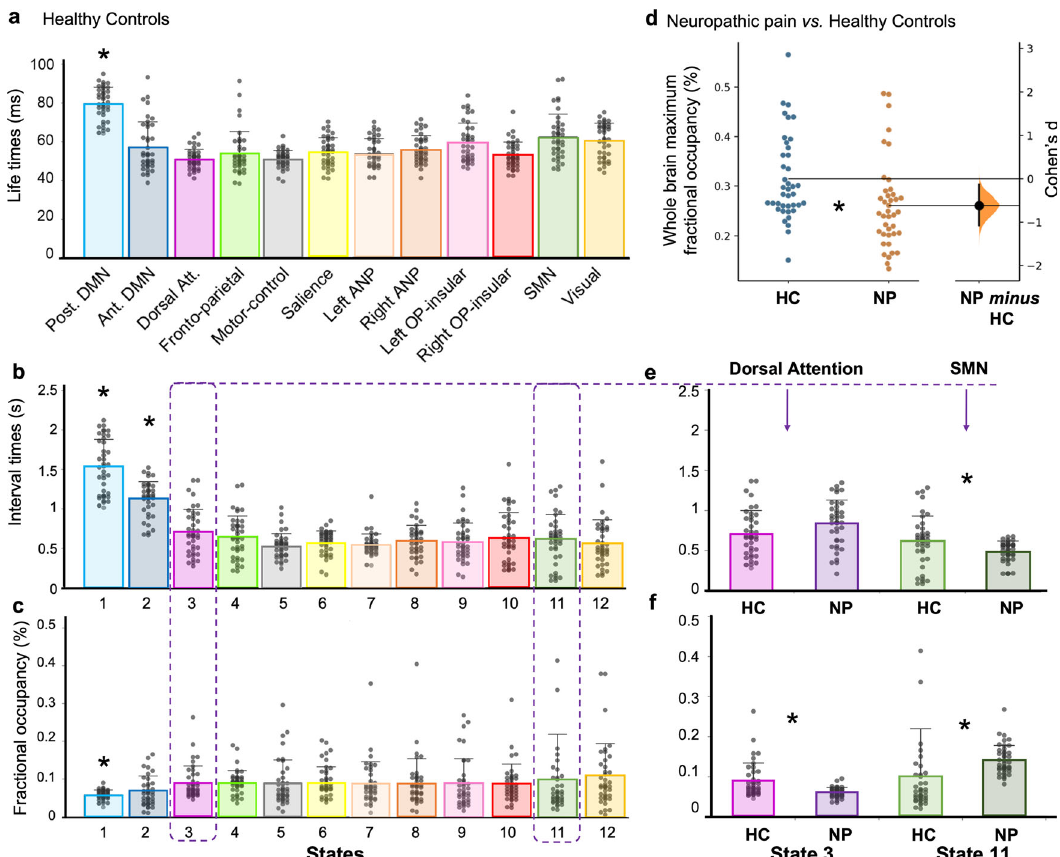
Fig. 5 Brain states temporal features: chronnectome in healthy controls and disturbances associated with neuropathic pain. a Distribution of state life times, b distribution of interval times between state visits, and c fractional occupancies (proportion of time spent in each state) are depicted for the n = 40 healthy controls group. The two states related to the default mode network (DMN) have distinct temporal features compared with the other states. The posterior DMN state had higher lifetimes, and both posterior and anterior DMN states had higher interval times, but the proportion of time spent in the posterior DMN state was lower compared to the other states ( P < 0.01). In n = 40 participants with neuropathic pain, d the maximum fractional occupancy was lower, and e the sensorimotor (SMN) was more frequently active compared with n = 40 healthy controls. f The proportion of time spent was higher in the SMN state and lower in the dorsal attention state compared to healthy controls. Standard deviations are shown. * P < 0.01; permutation P value, 5000 bootstrap samples. DMN Default mode network, SMN sensorimotor, HC healthy control, NP neuropathic